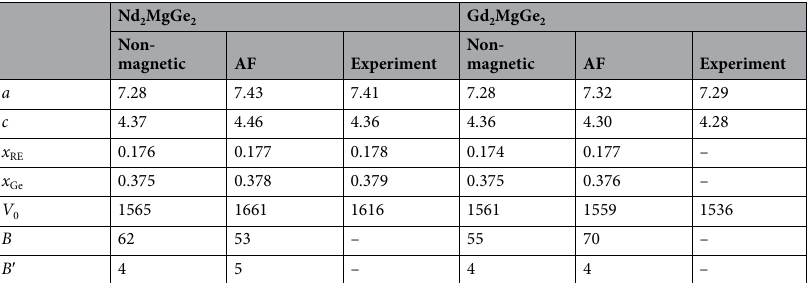
Table 1. Lattice parameters ( a , c in Å), internal parameters ( x RE , x Ge ), equilibrium volume ( V 0 in Bohr 3 ), bulk modulus at 0 K ( B in GPa), and pressure derivative of the bulk modulus ( B ′ ). Experimental values from Refs. 48,49 are given for comparison.